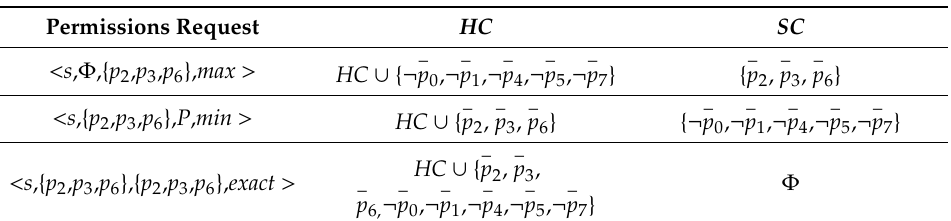
Table 4. Updated clauses.